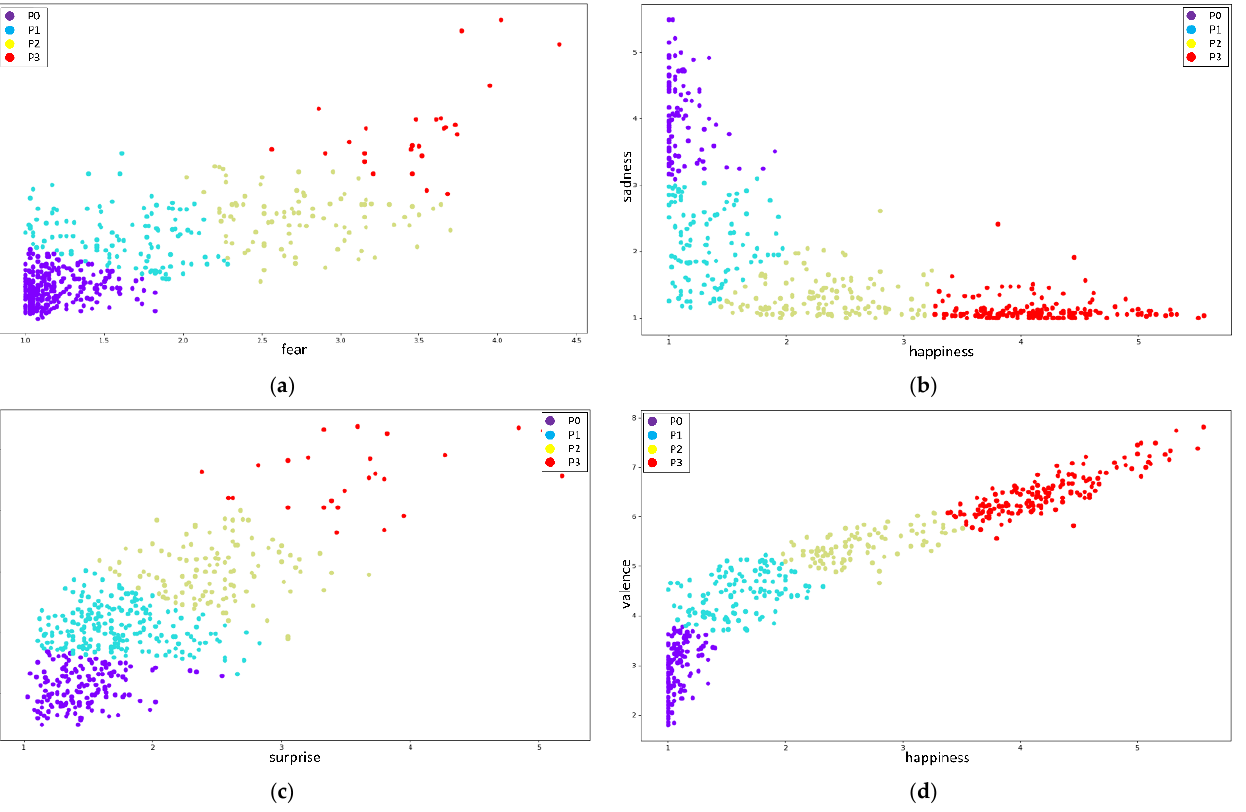
Figure 9. After p = 2000 iterations of Monte-Carlo stabilized k -means algorithm ( k = 4), cluster distribution of transformations between discrete and dimensional models in the NAPS BE dataset was achieved for the following specific emotion tuples: ( a ) {fear, surprise}; ( b ) {happiness, sadness}; ( c ) {surprise, arousal}; ( d ) {happiness, valence}.